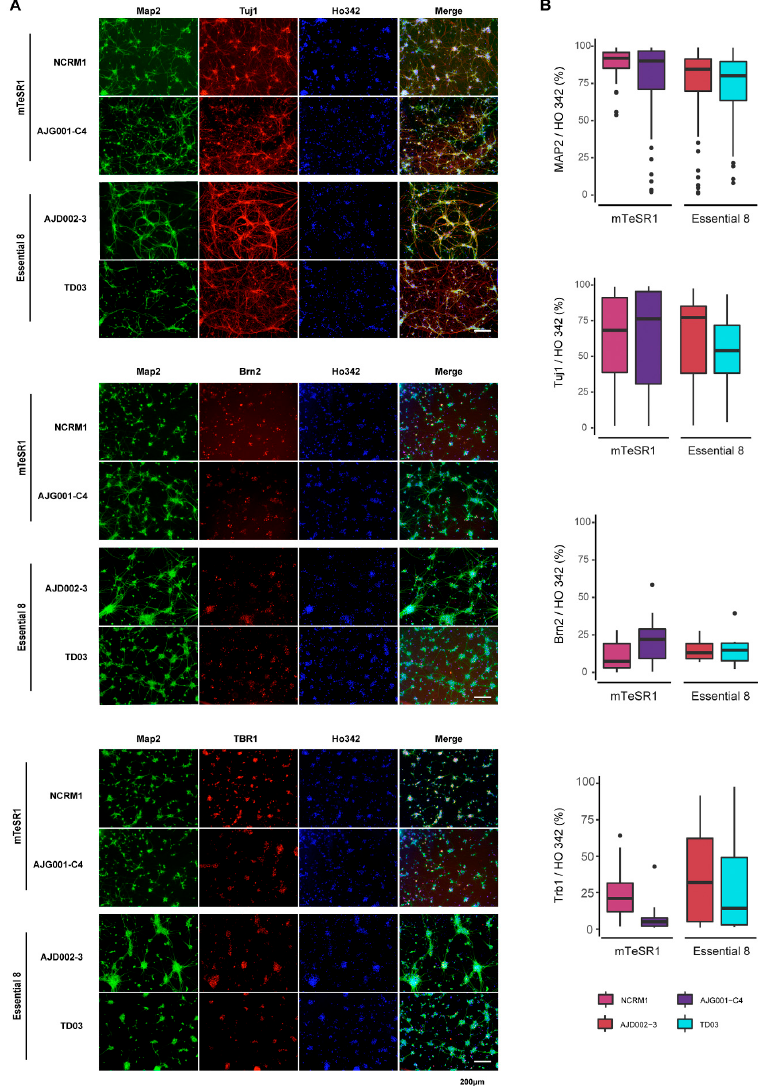
Figure 7. Immunocytochemistry staining of hiPSC-derived cortical neurons. ( A ) Representative images of ICC-stained cortical neurons from AJG001-C4, NCRM1, AJD002-3, and TD03 after 4 weeks of neuronal differentiation. Cells were stained with MAP2 and Tuj1 neuronal markers, and cortical neuron markers Brn2 and Tbr1. Nuclei were counterstained with Ho342. ( B ) Quantification of MAP2-, Tuj1-, Brn2-, or Tbr1-positive cells in ( A